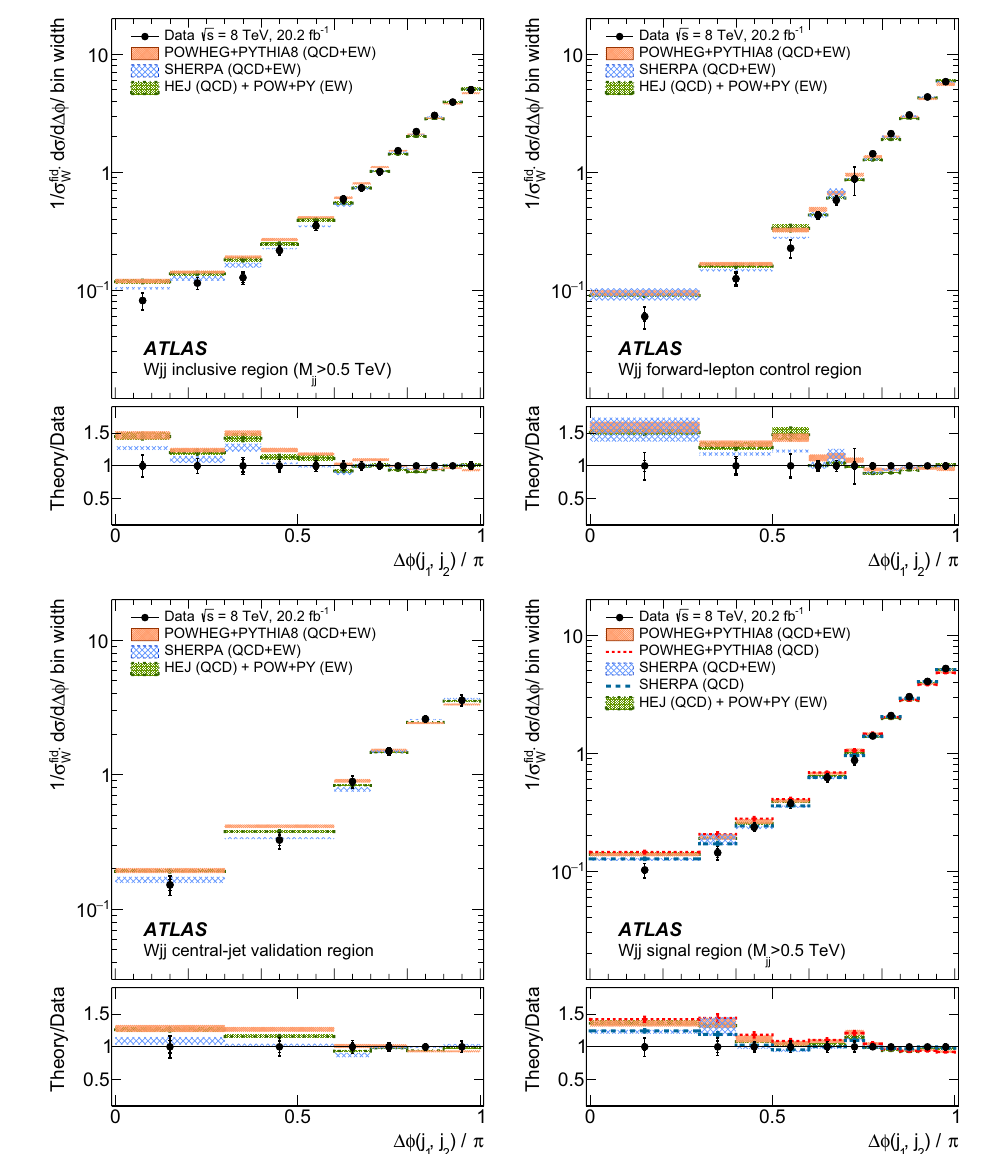
Fig. 27 Unfolded normalized differential W jj production cross sec- tions as a function of (cid:6)φ( j 1 , j 2 ) for the inclusive, forward-lepton con- trol, central-jet validation, and signal fiducial regions. Both statistical